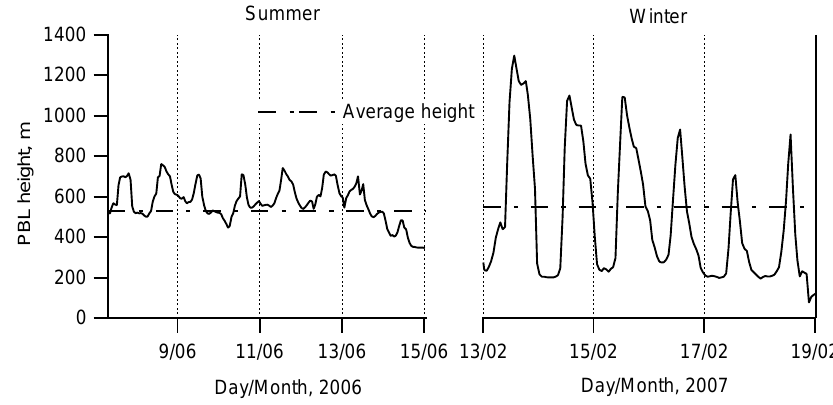
Fig. 6. Planetary boundary layer (PBL) heights for the sampling periods in Mumbai, which are computed using “weather research and forecasting reference” software (WRF of Mesoscale and Microscale Meteorology Division, National Center for Atmospheric Research, Boulder).